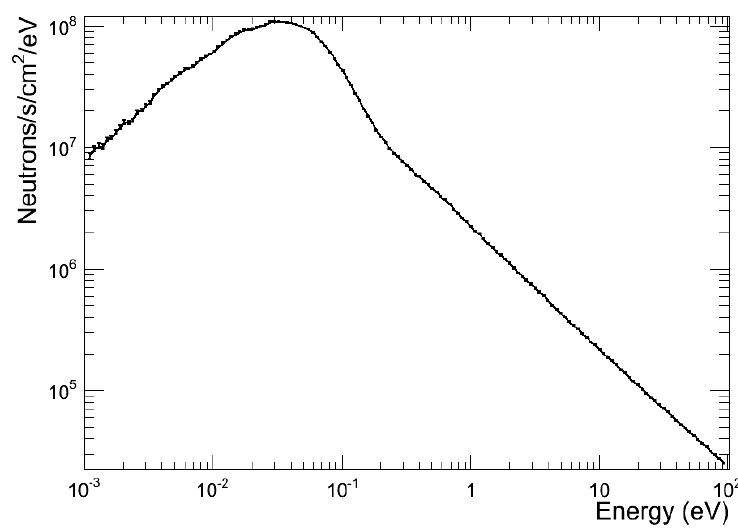
Figure 2. The total neutron energy spectra produced by the Lujan Center. The spectra were calculated with the maximum proton beam currents of 125 μ a for the Lujan Center [31].